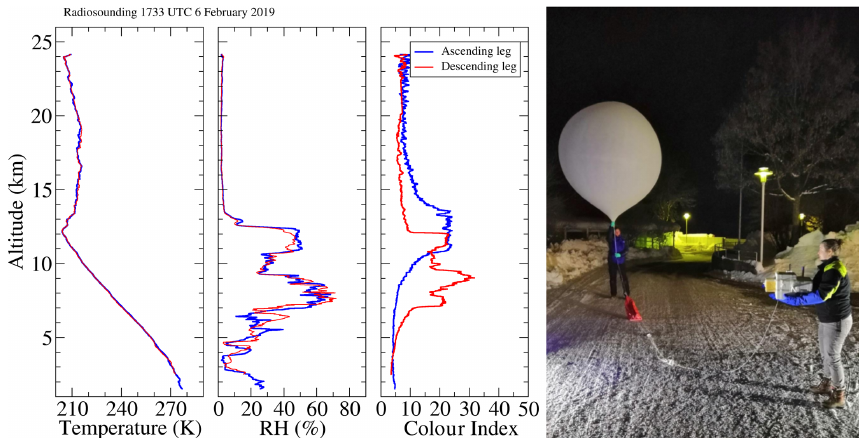
Figure 4. Radio soundings from Garmisch-Partenkirchen of temperature, relative humidity (RH), and colour index profiles for the launch on 6 February 2019, 17:33UTC. A single cloud layer during the ascending leg (blue curve) and a double layer during descending (red curve) are shown in the colour index